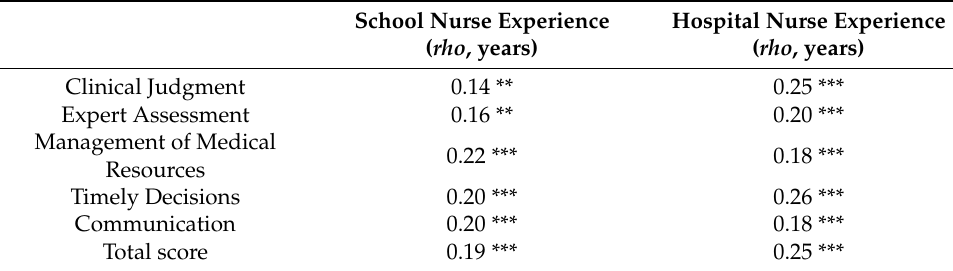
Table 2. Correlations between the triage competency subdomains and work